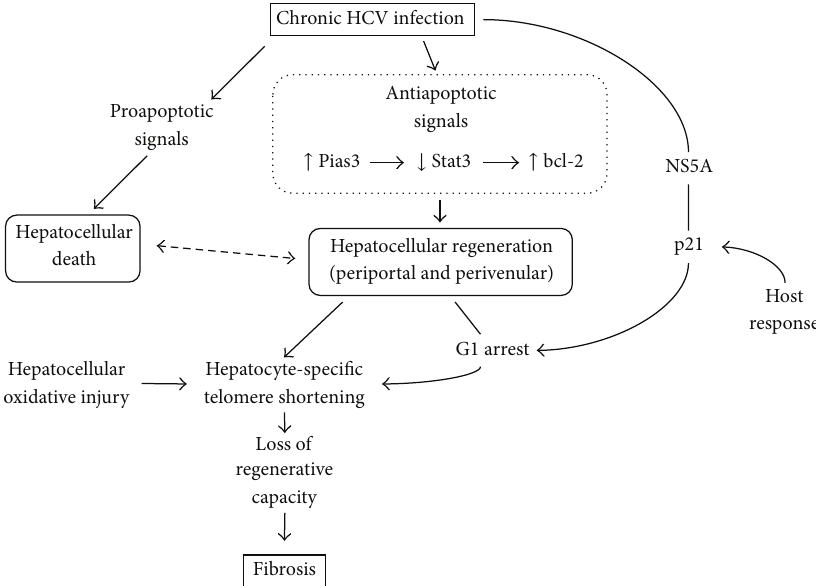
Figure 1: Outline of hepatocellular turnover in chronic HCV infection (see text for description). Stat: signal transducer and activator of transcription; Pias: protein inhibitor of activated Stat; NS5A: nonstructural 5A